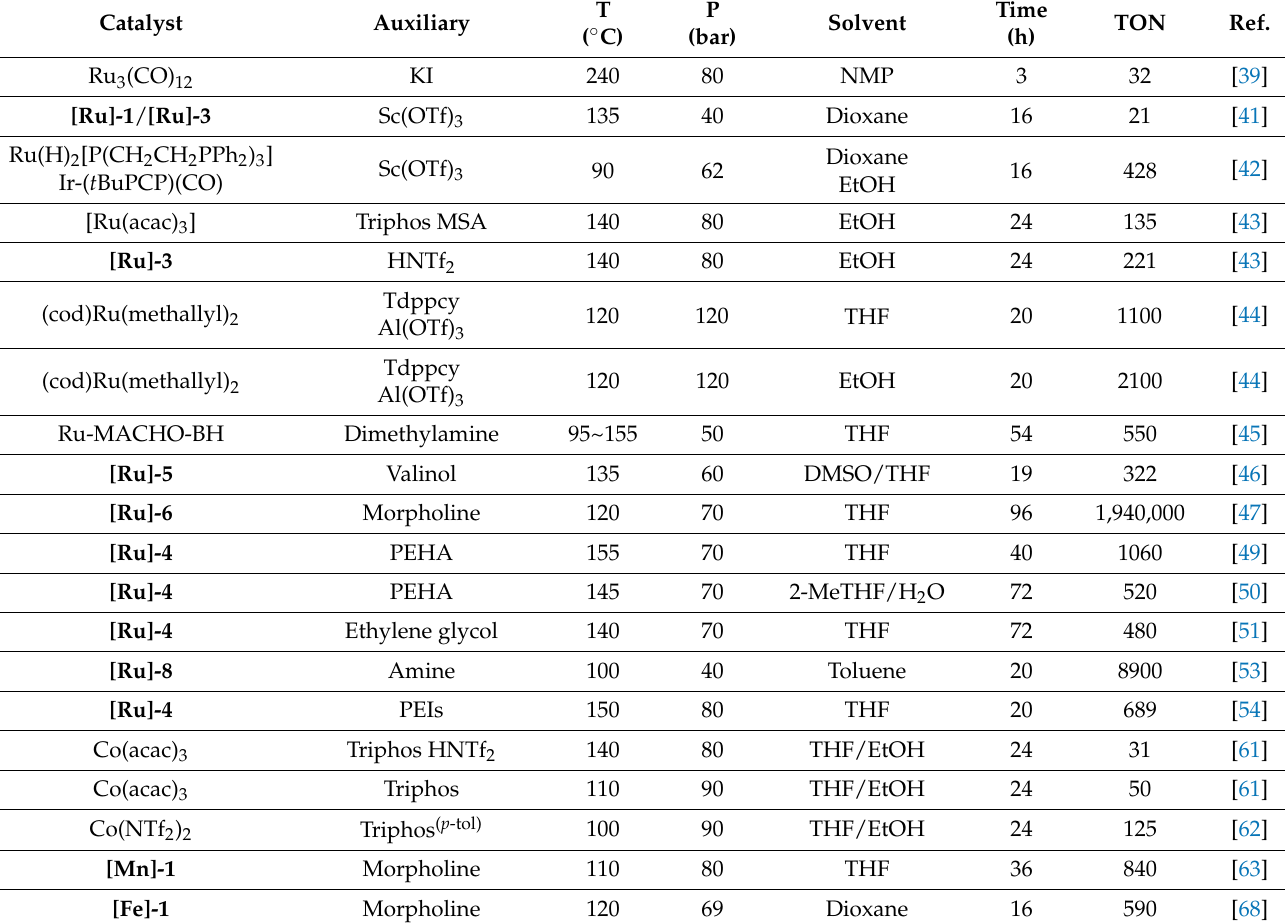
Table 1. Molecular catalysts for CO 2 hydrogenation to